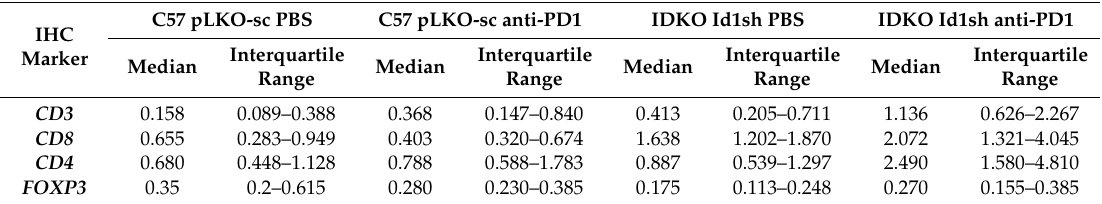
Table 2. Immunohistochemical analysis of markers of tumor infiltrating lymphocytes from Id1 +/+ / DPBS (pLKO-sc LLC), Id1 +/+ / anti-PD1 (pLKO-sc LLC), Id1 - / - DPBS ( Id1 sh LLC), and Id1 - / - / anti-PD1 ( Id1 sh LLC)